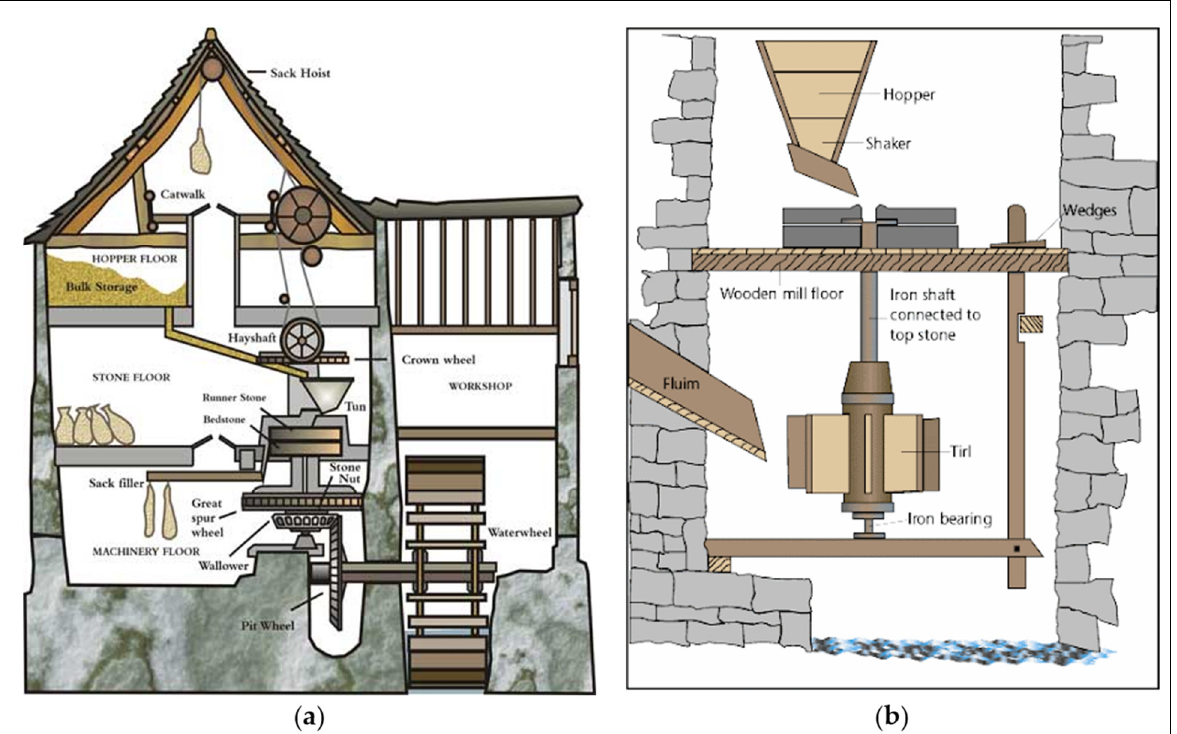
Figure 2. Basic types of water mills: ( a ) powered by a vertical water wheel and ( b ) equipped with a horizontal water wheel.